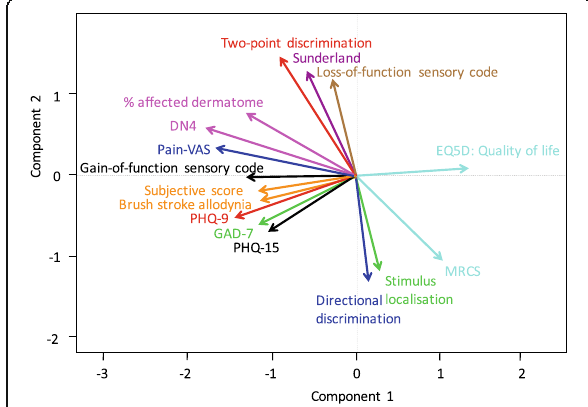
Fig. 6 Biplot of all objective and subjective neurosensory measurements. An acute angle indicates a positive correlation. A 90- degree angle indicates no correlation between the two variables, and an obtuse angle indicates a negative correlation. There was a negative correlation of quality of life with gain-of-function sensory code, brush stroke allodynia, and percentage of affected dermatome. In addition, the other questionnaire scores (PHQ-15, GAD-7, PHQ-9, subjective score, Pain-VAS, and DN4) correlated positively with sensory gain-of-function, brush stroke allodynia, and percentage of affected dermatome. Little to no correlation was identified between the different questionnaire scores and the objective measurements of stimulus localization, directional discrimination, two-point discrimination, Sunderland score, and sensory loss-of-function